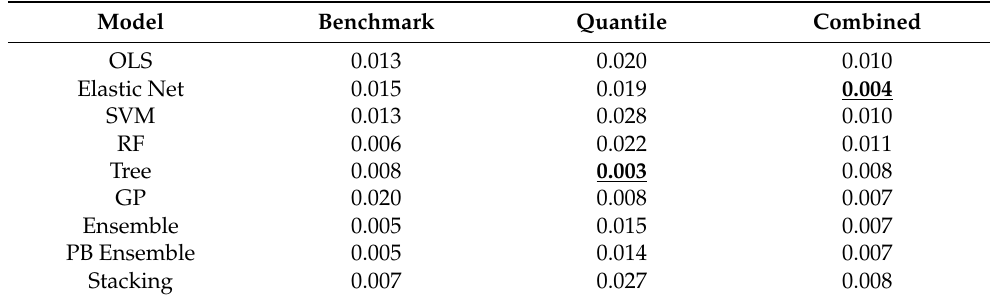
Table 3. Predictive accuracy for daily aggregations-mae–lowest error underlined in